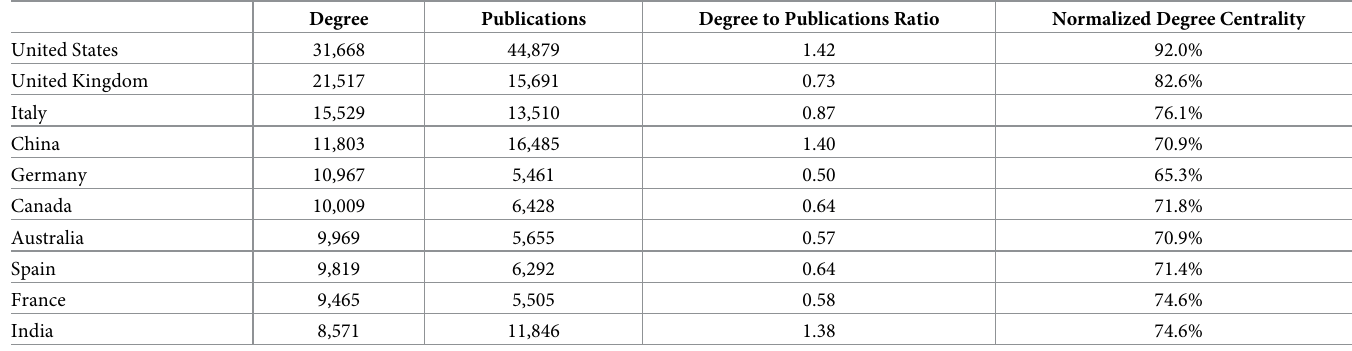
Table 2. The Degree, publications, Degree to publications ratio, and the Normalized Degree Centrality of the leading ten countries in COVID-19